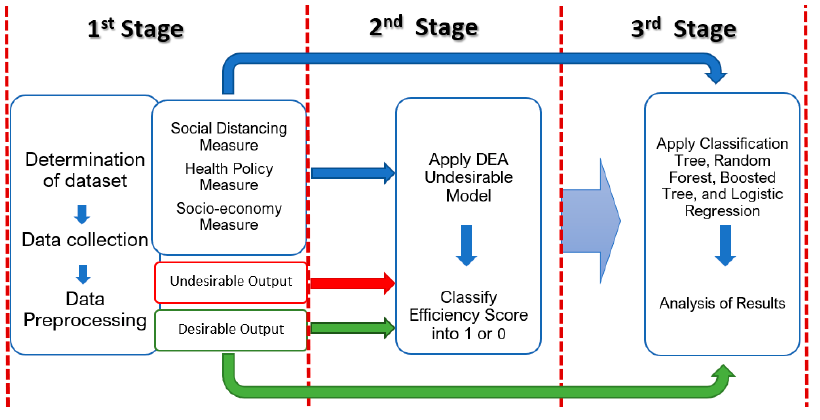
Figure 1. DEA and ML Methodology Frameworks.